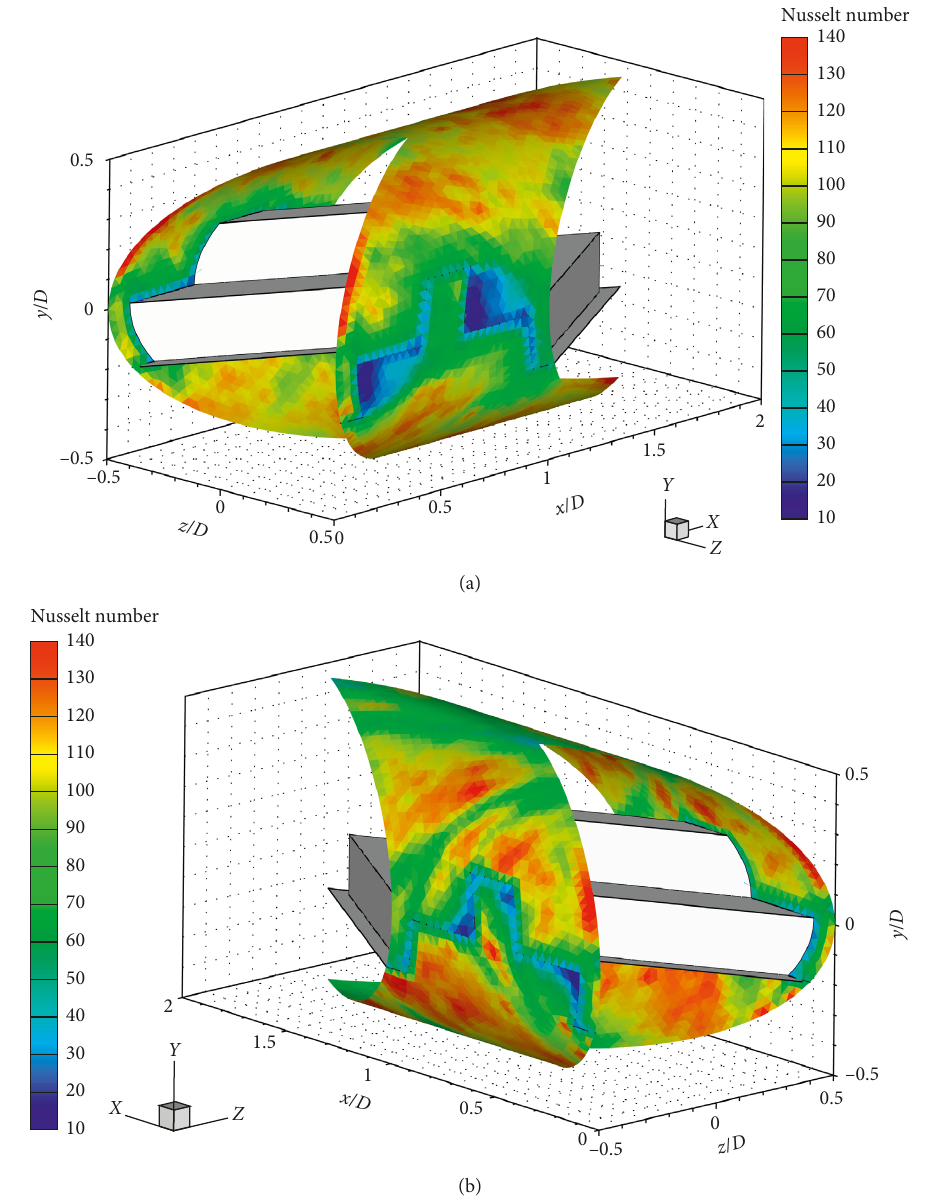
Figure 20: Local Nusselt number contour on the tube wall of the heat exchanger tube inserted with the V-wavy surface at α 6000 for (a) V-Downstream and (b)